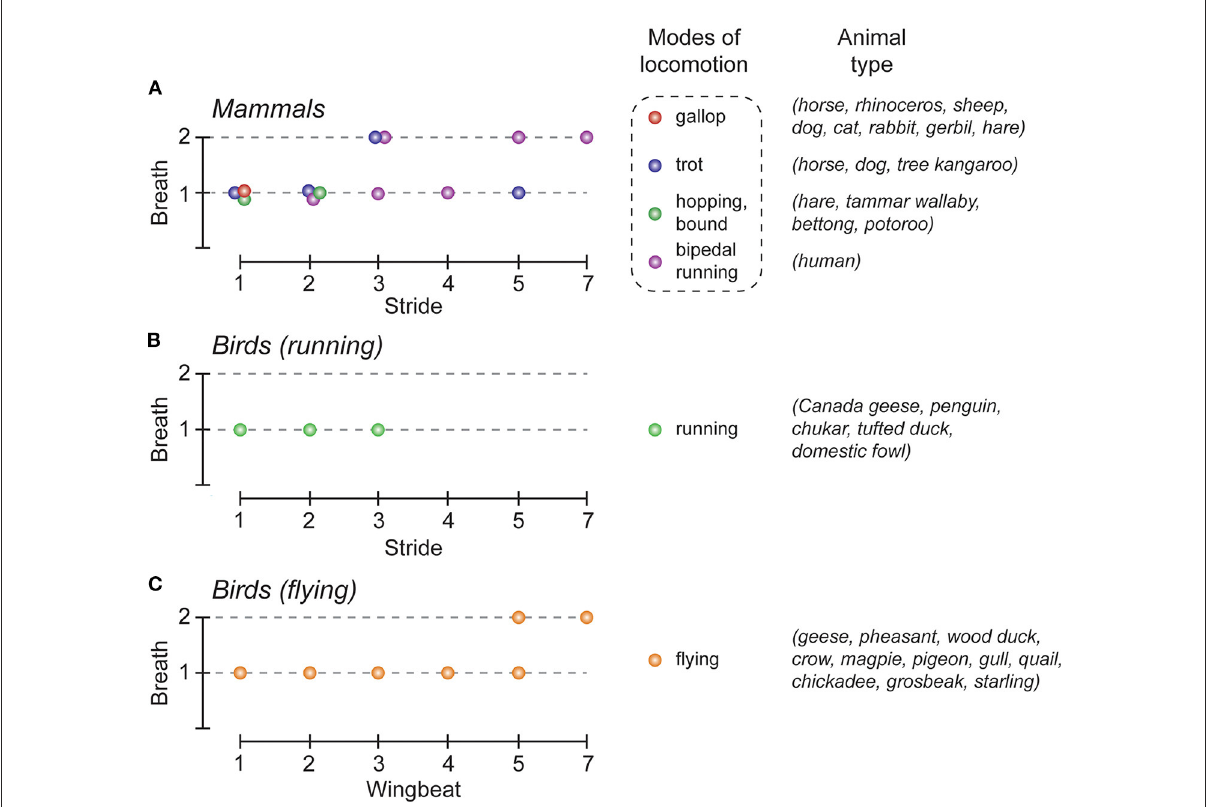
FIGURE1 Locomotor-respiratory coupling (LRC) ratios in the animal kingdom. (A–C) , Graphical representation of the most common LRC ratios observed in mammals (A) , and birds (B,C) . The colored dots indicate the LRC ratios commonly observed, depending on the mode of locomotion used, in mammals (red, gallop; blue, trot; green, hopping/bond; purple, bipedal running), and birds (green, running; orange, flying). Note that for the same gait either one (e.g. gallop) or several (e.g., trot) LRC can be observed. Adapted from Boggs (2002), Stickford and Stickford